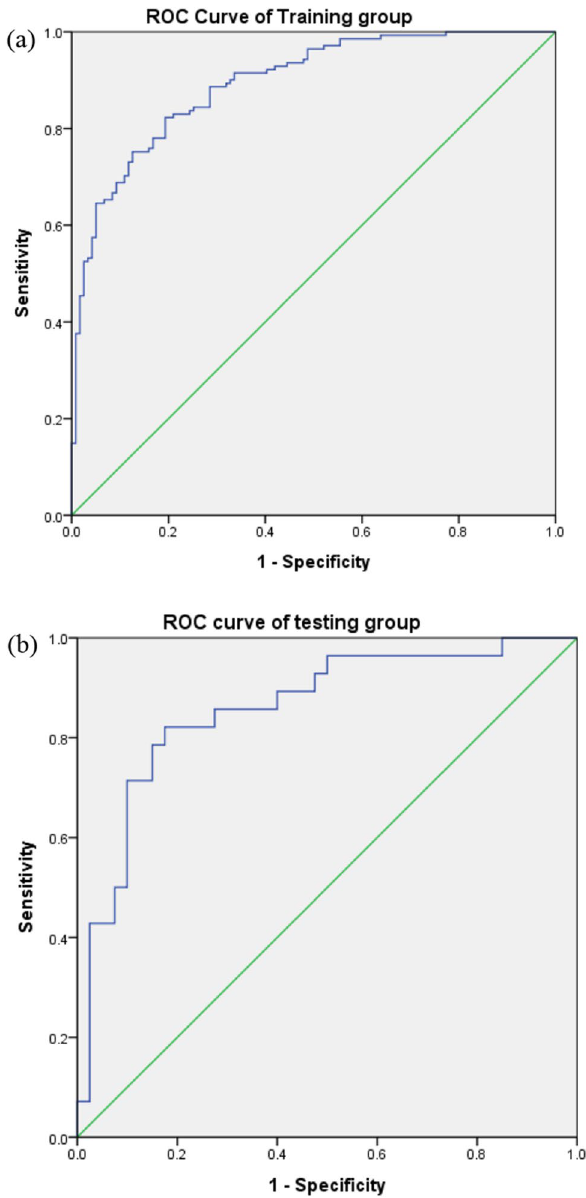
Figure 1. ( a ) The diagnostic power of BD-II of the training group using receiver operating characteristic (ROC) curve analysis. (AUC = 0.89, 95% CI = 0.86–0.93, P < 0.001), ( b ) the diagnostic power of BD-II of testing group using receiver operating characteristic (ROC) curve analysis (AUC = 0.86, 95% CI = 0.77–0.91, P <